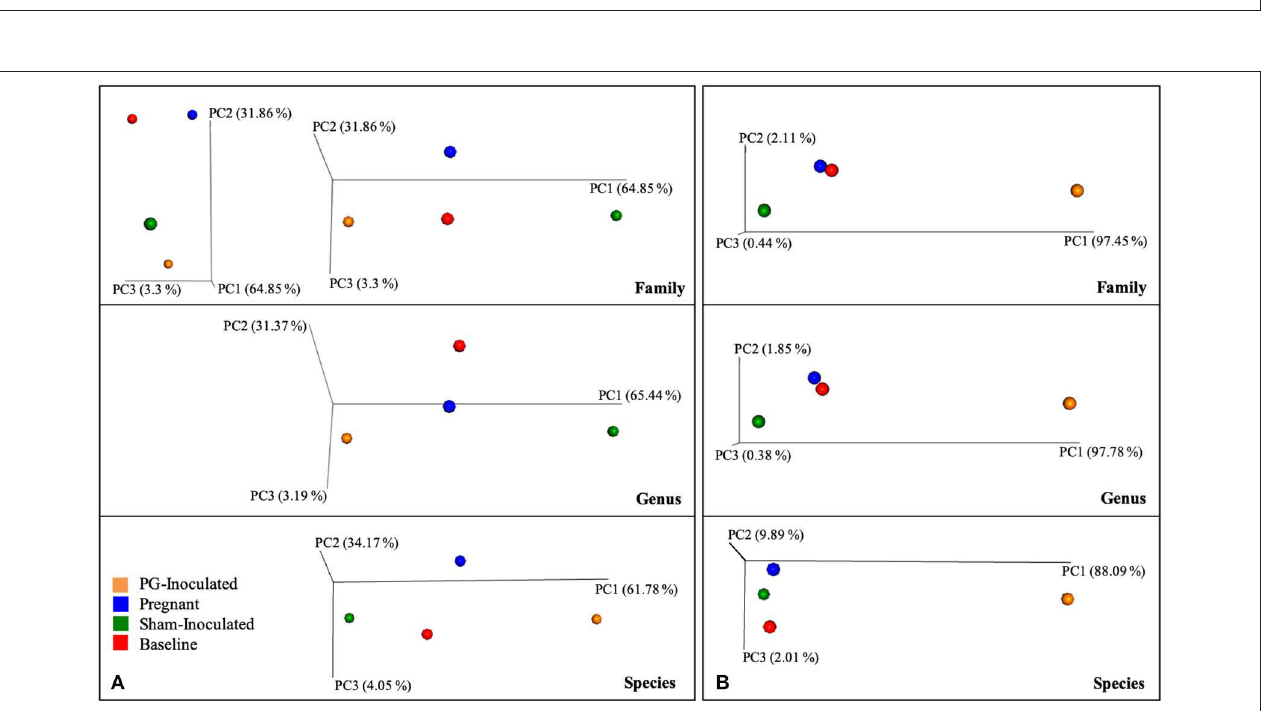
FIGURE 8 | Collective consensus microbiome at the family, genus, or species level and plotted as four data points in PCoA plots using (A) Bray Curtis or (B) Eucledian of beta diversity measures of dissimilarity.